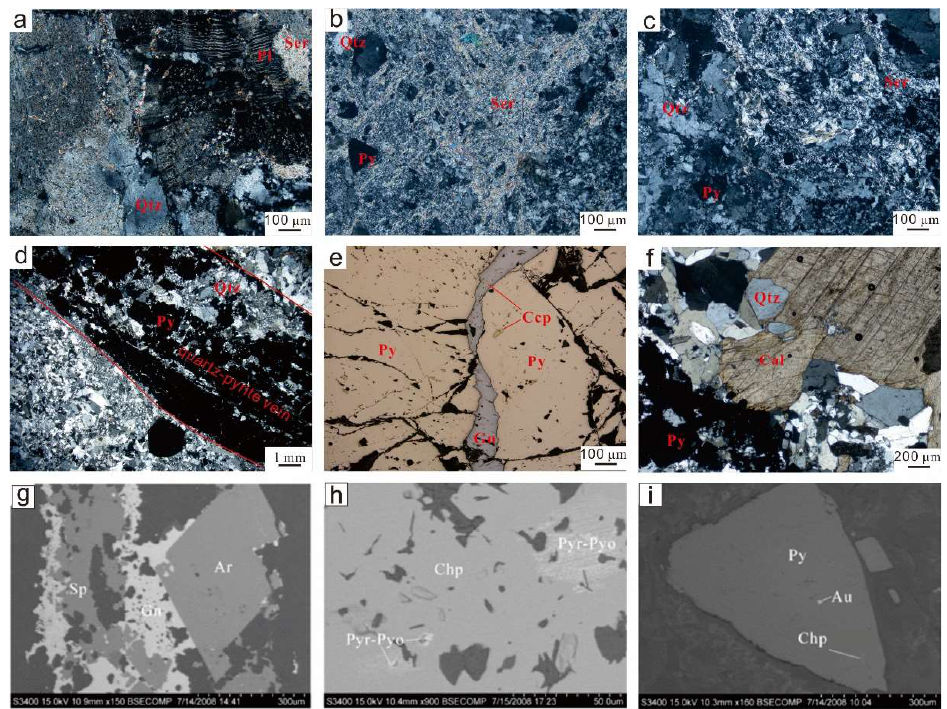
Figure 4. Photomicrographs under ( a – d , f ) transmitted light, ( e ) reflected light and ( g – i ) backscattered electron images, showing important ore minerals and alteration assemblages at the Sanshandao gold deposit. (a–c) Typical sericitization alteration consisting of sericite and quartz, with minor pyrite (stage 1); (d) quartz–pyrite vein (stage 2) occurring in sericite–quartz altered rock; (e) galena cemented